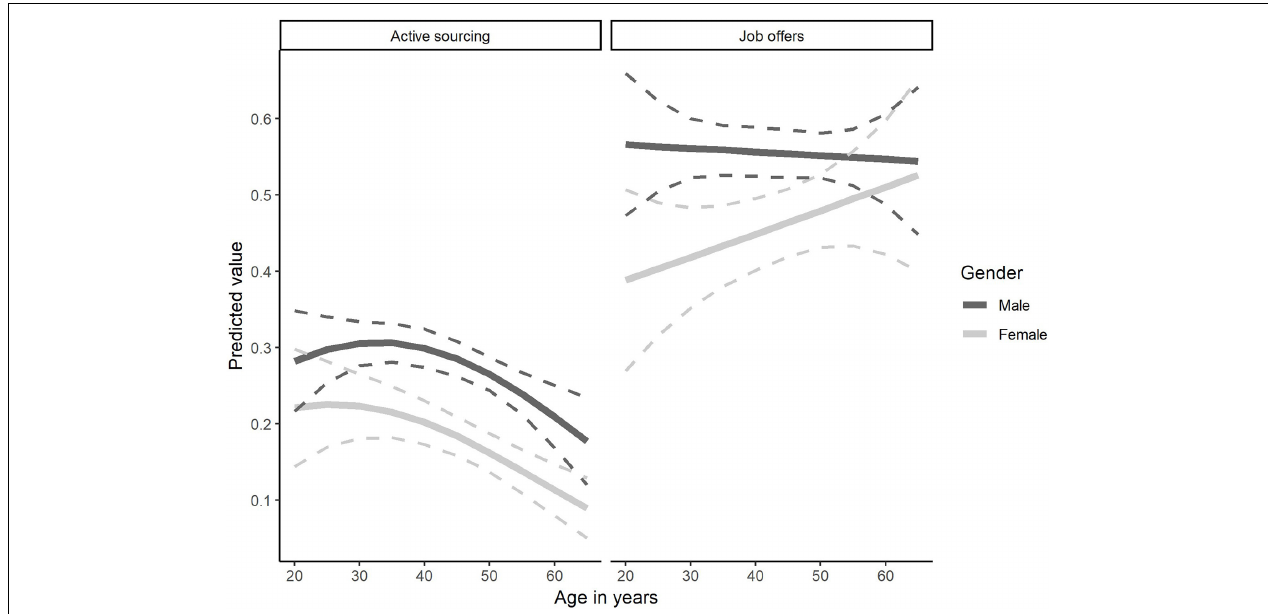
FIGURE 4 | Predicted values for age and gender. The left side refers to active sourcing, the right side to job offers. The dark lines represent the effects for male employees, the lighter lines the effects for female employees. Solid lines represent the predicted values over the ages. The dashed lines indicate the 95% confidence